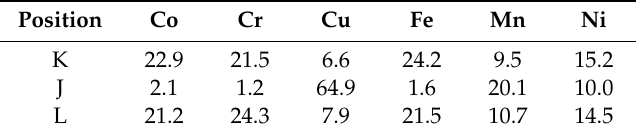
Table 3. Chemical composition analysis results of the ratio of metallic element without considering B